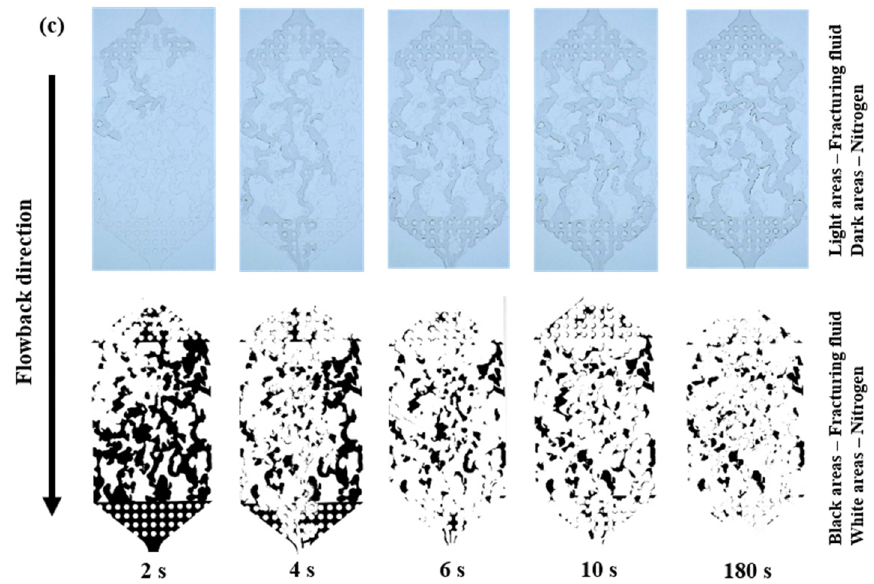
Figure 6. The fracturing fl uid (0.1 wt%) fl owback process images and binary images ( a ) 0.1 MPa gas drive, ( b ) 0.2 MPa gas drive, ( c ) 0.3 MPa gas drive.